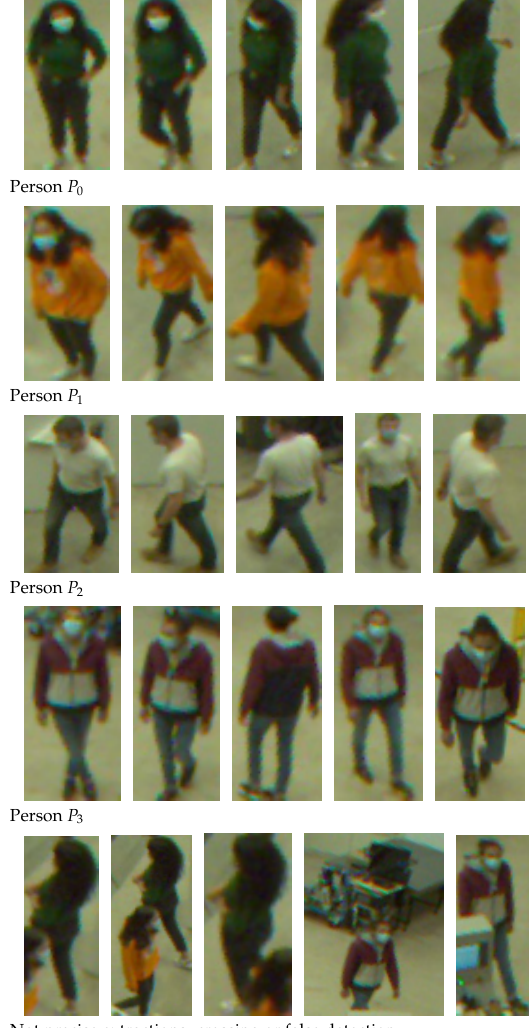
Figure 11. Extractions of the four persons from the first video (namely P i , i ∈{ 0,1,2,3 } ) and extractions where there is more than one person (bottom). Note that images are unwrapped for displaying and of different